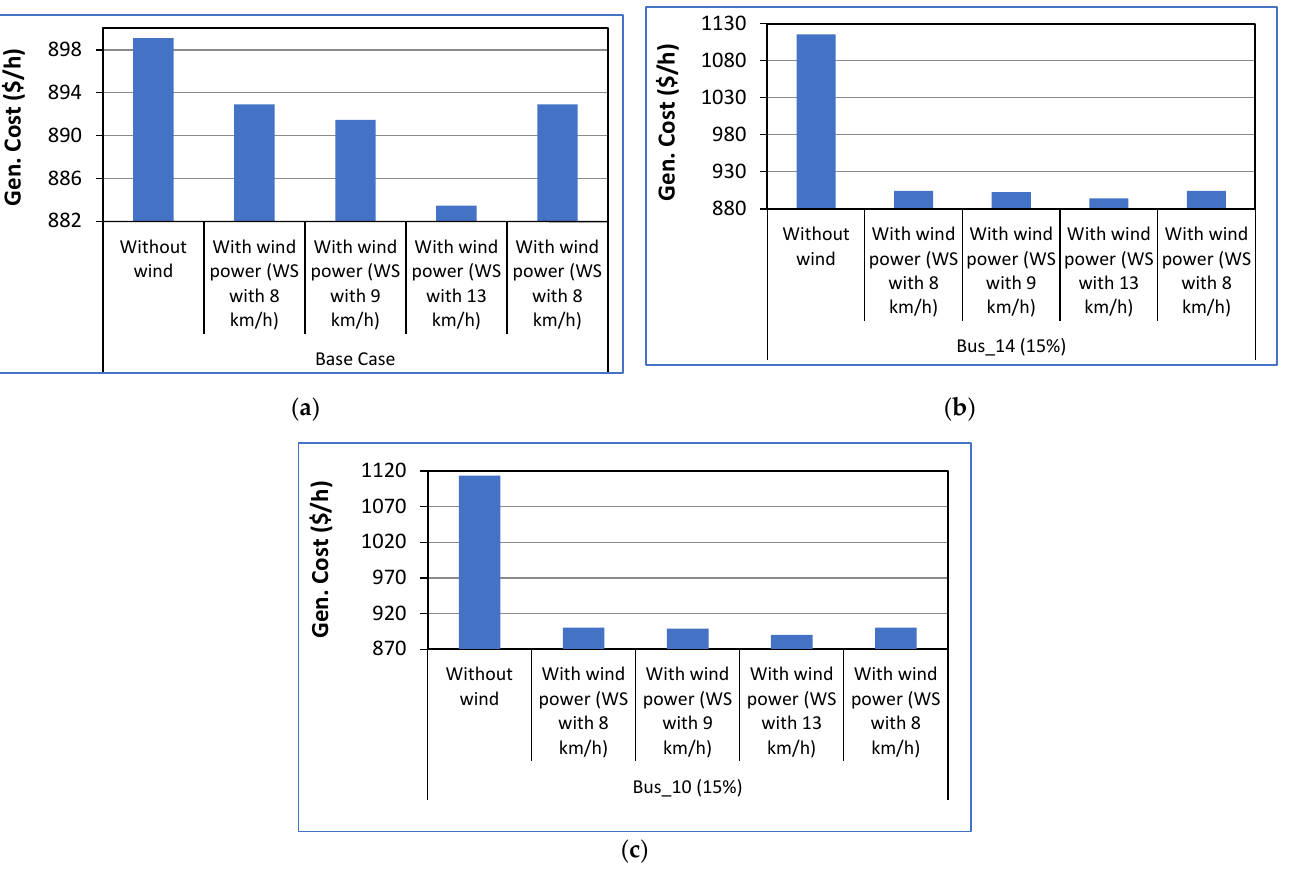
Figure 3. System Risk with Wind Power Integration (Vijayawada @Base Case). VaR based on NP